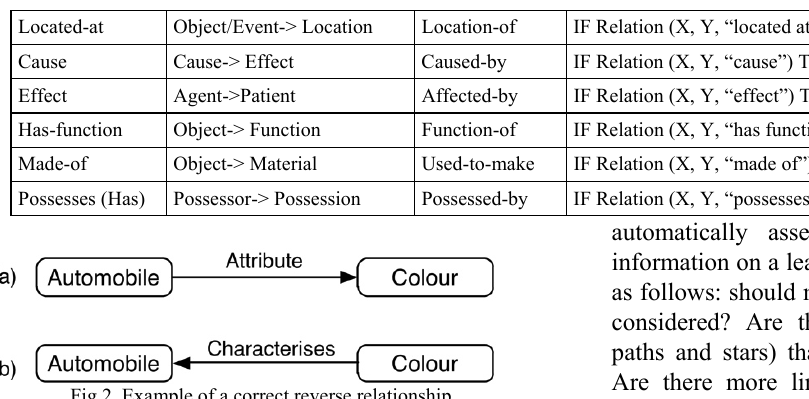
Fig.2. Example of a correct reverse